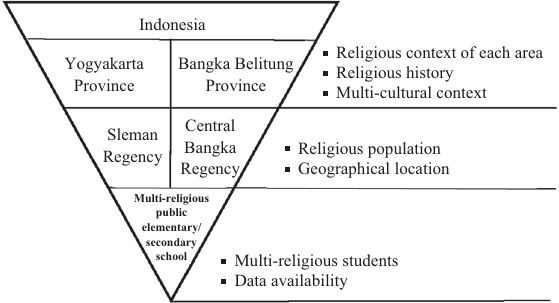
Fig. 2 Research sampling technique. Top-down reasons for the research